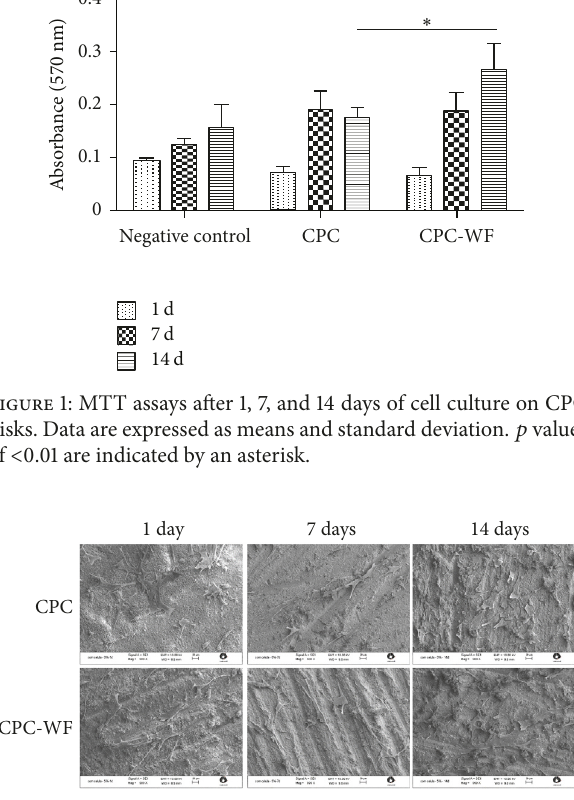
Figure 2: Scanning electron micrographs of CPC and CPC-WF disks after 1, 7, and 14 days of culture. Osteoblast-like cells were well adhered, and the topography of the material did not interfere with cell adhesion.